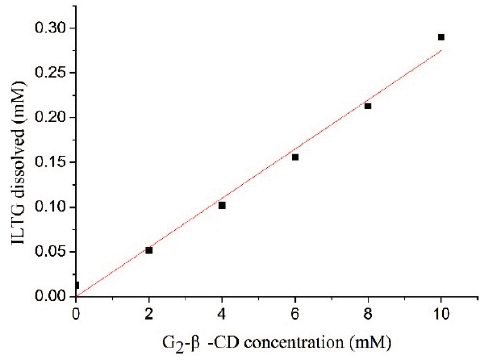
Figure 2. Phase–solubility diagram of the complexes formed by ILTG and G 2 - β